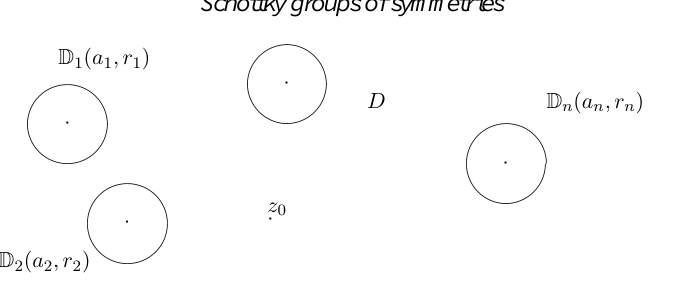
Figure 1. A multiply connected